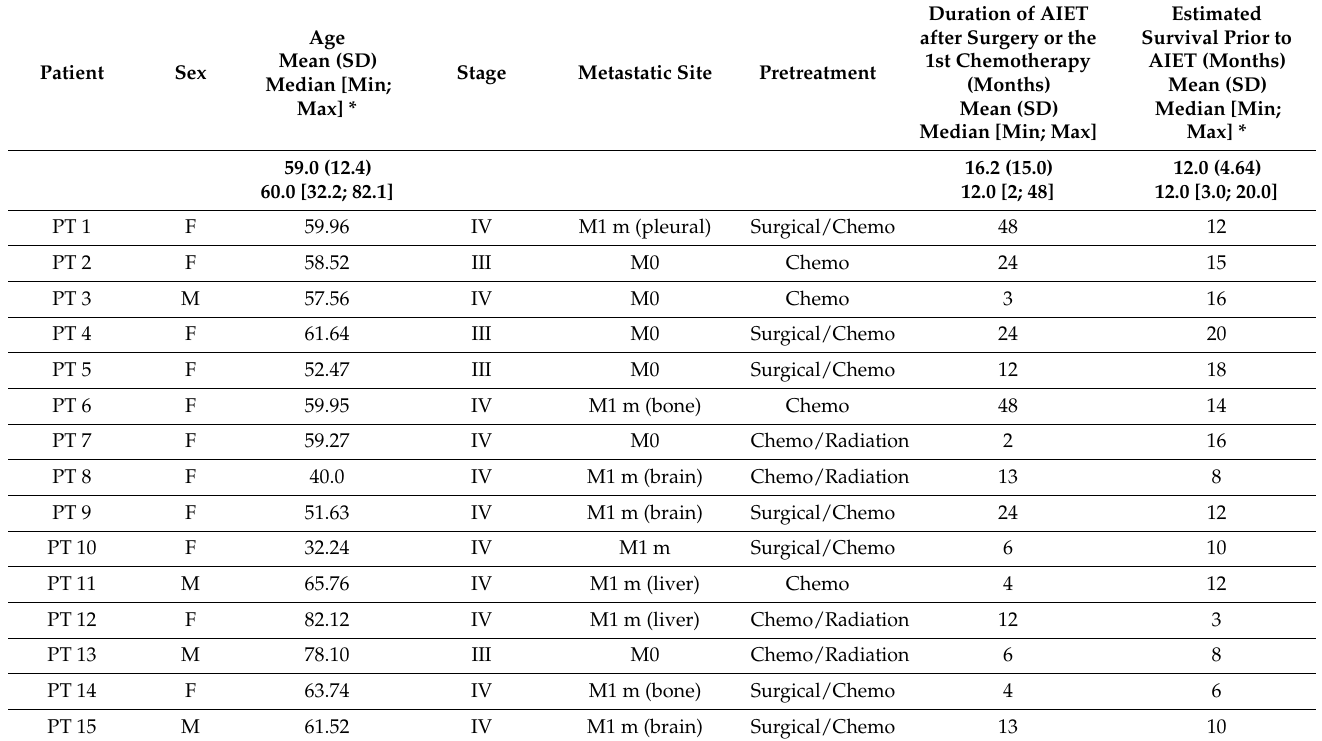
Table 1. Details of the patients enrolled in this